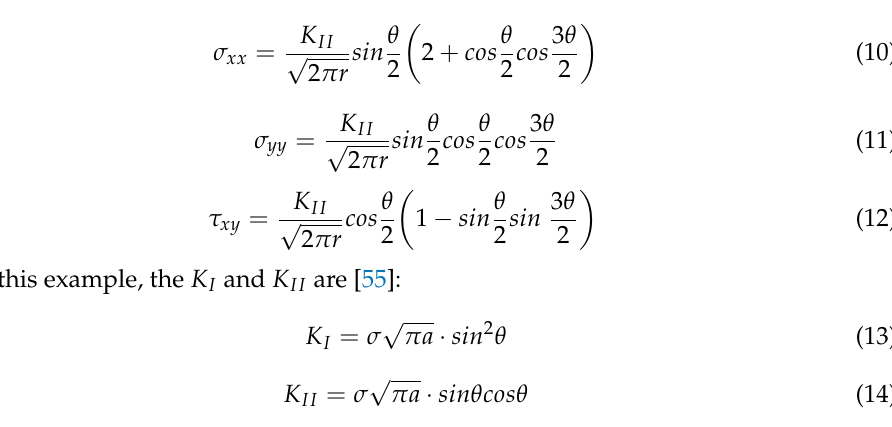
model to represent the crack as